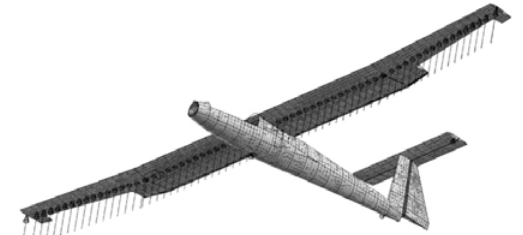
Fig 9. Forces and constrains simulating symmetrical steady flight